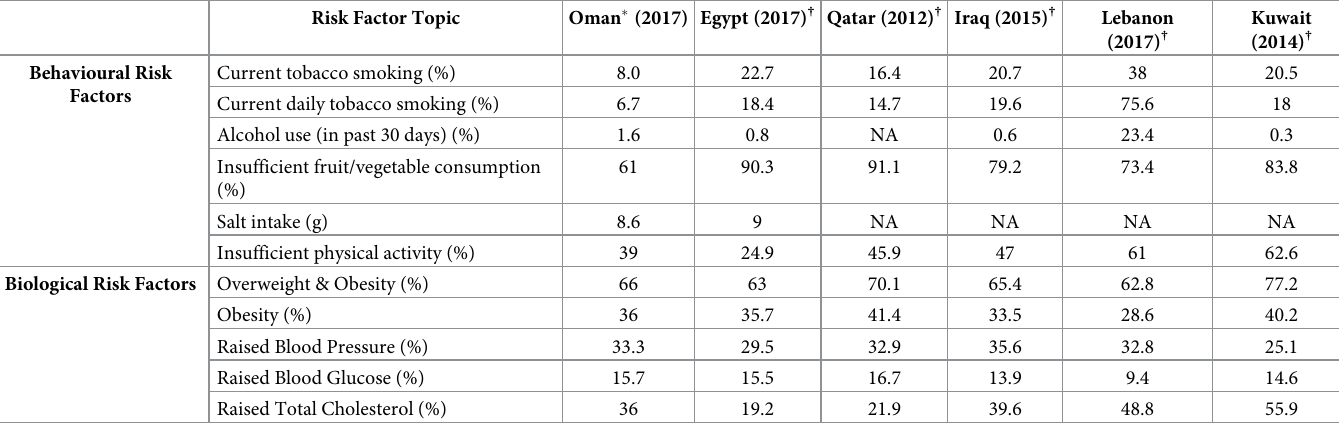
Table 6. Comparison of risk factors from recent STEPS surveys in various EMRO